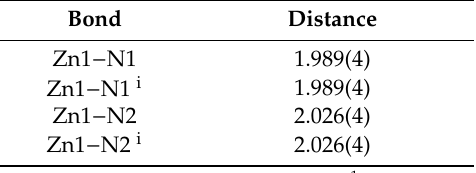
Table 3. Bond lengths to Zn(II) ion (Å) for ( 3